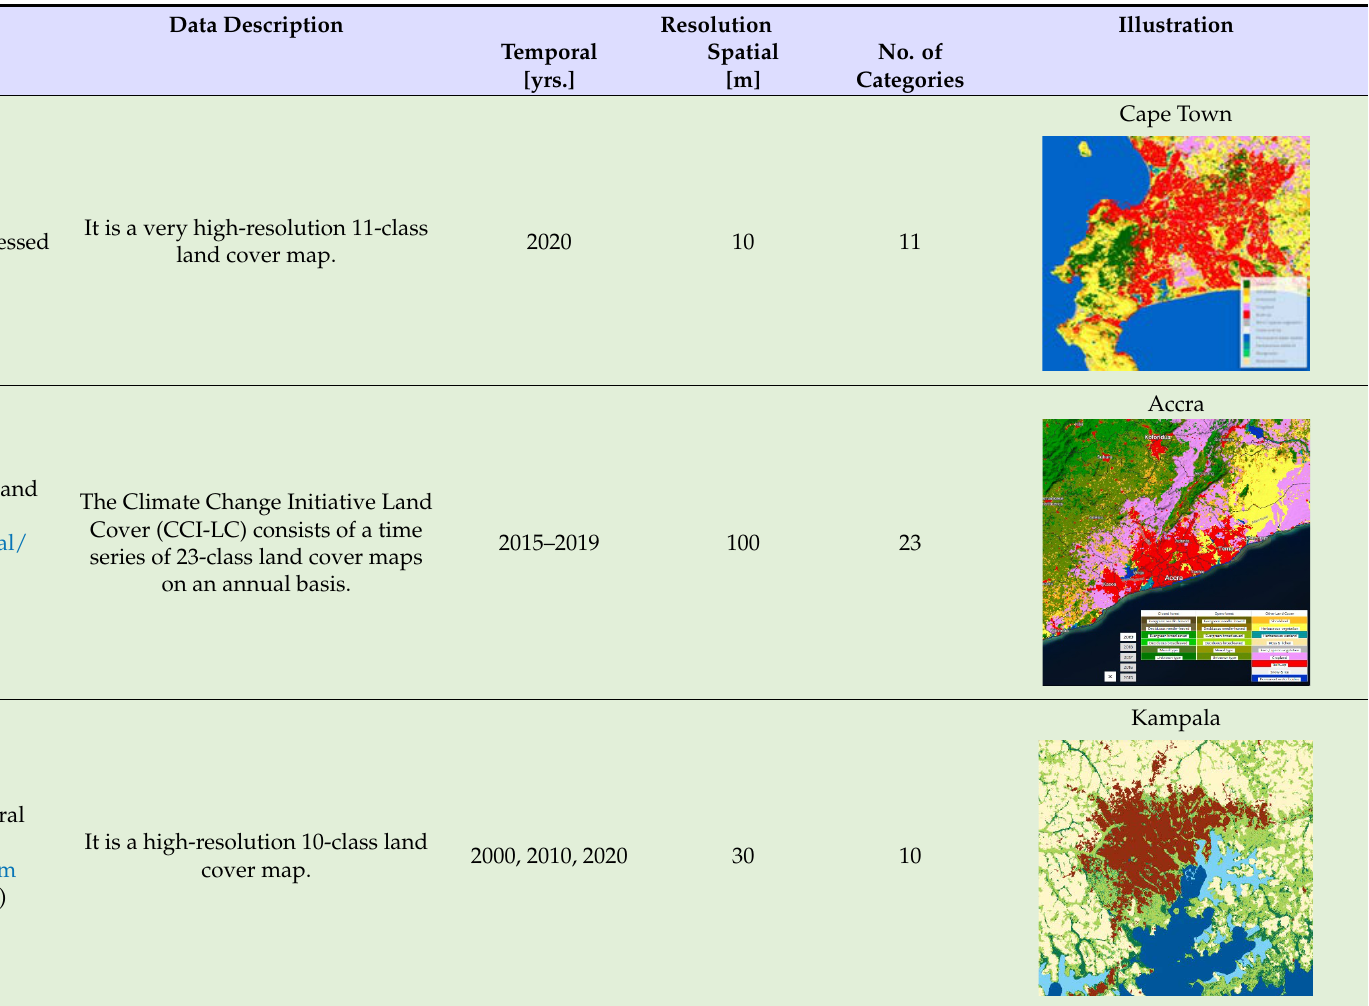
Table 1. Publicly available dataset revealing different characteristics of land cover.